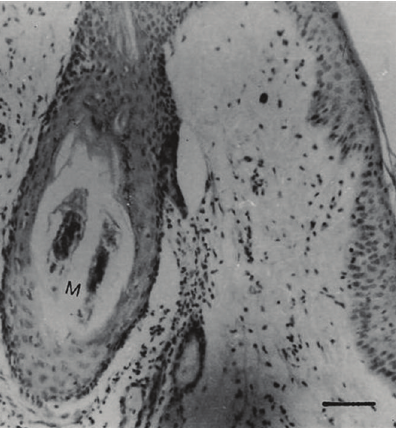
Figure 6: Section from the skin of a cow, showing invasion of a hair follicle with Demodex bovis . Note dilatation of the hair follicle bulb, mites (M), and slight infiltration by inflammatory cells in close proximity of the hair follicle. Haematoxylin and Eosin. Scale bar: 100 𝜇 m